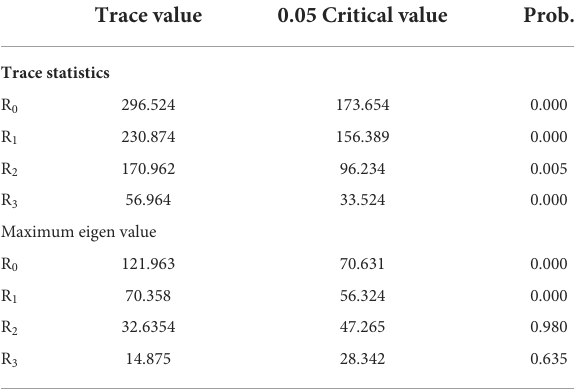
TABLE 6 Trace and eigen value